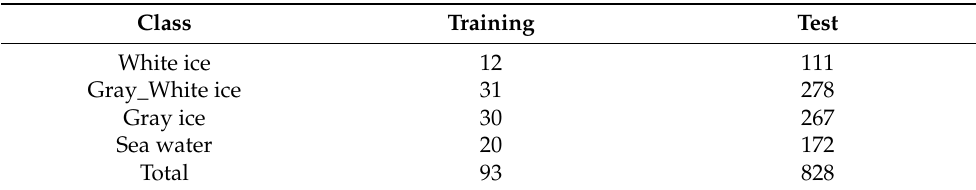
Figure 3. ( a ) False-color images with delineation of the experimental area (R: 30, G: 25, B: 18); ( b ) ground truth. Table 1. Number of training samples (pixels) and testing samples (pixels) in each class for the Bohai Bay data set.